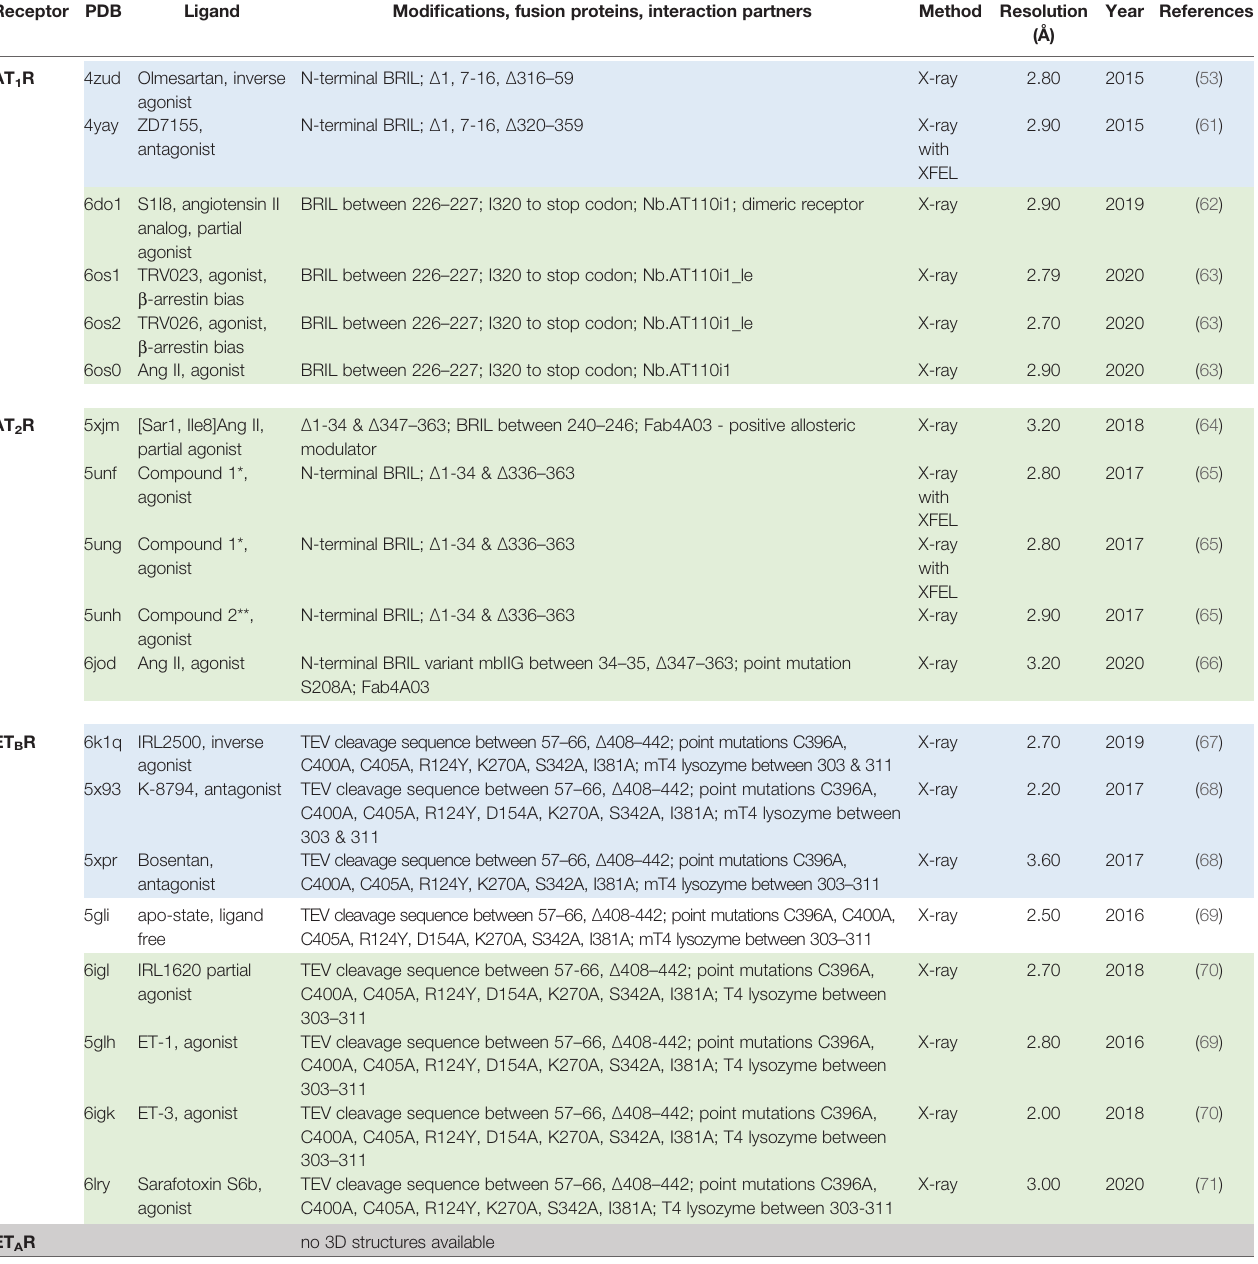
TABLE 1 | Overview of ETR and ATR structures known so far (as of January